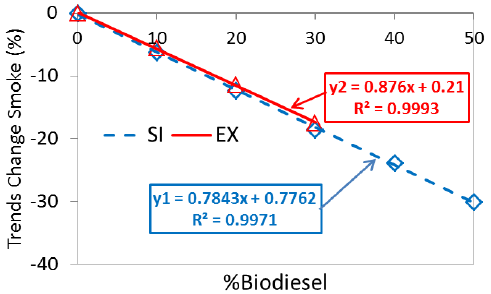
Figure 19. Trend of changes smoke according to biodiesel blend ratio of simulation (SI) and experiment (EX).